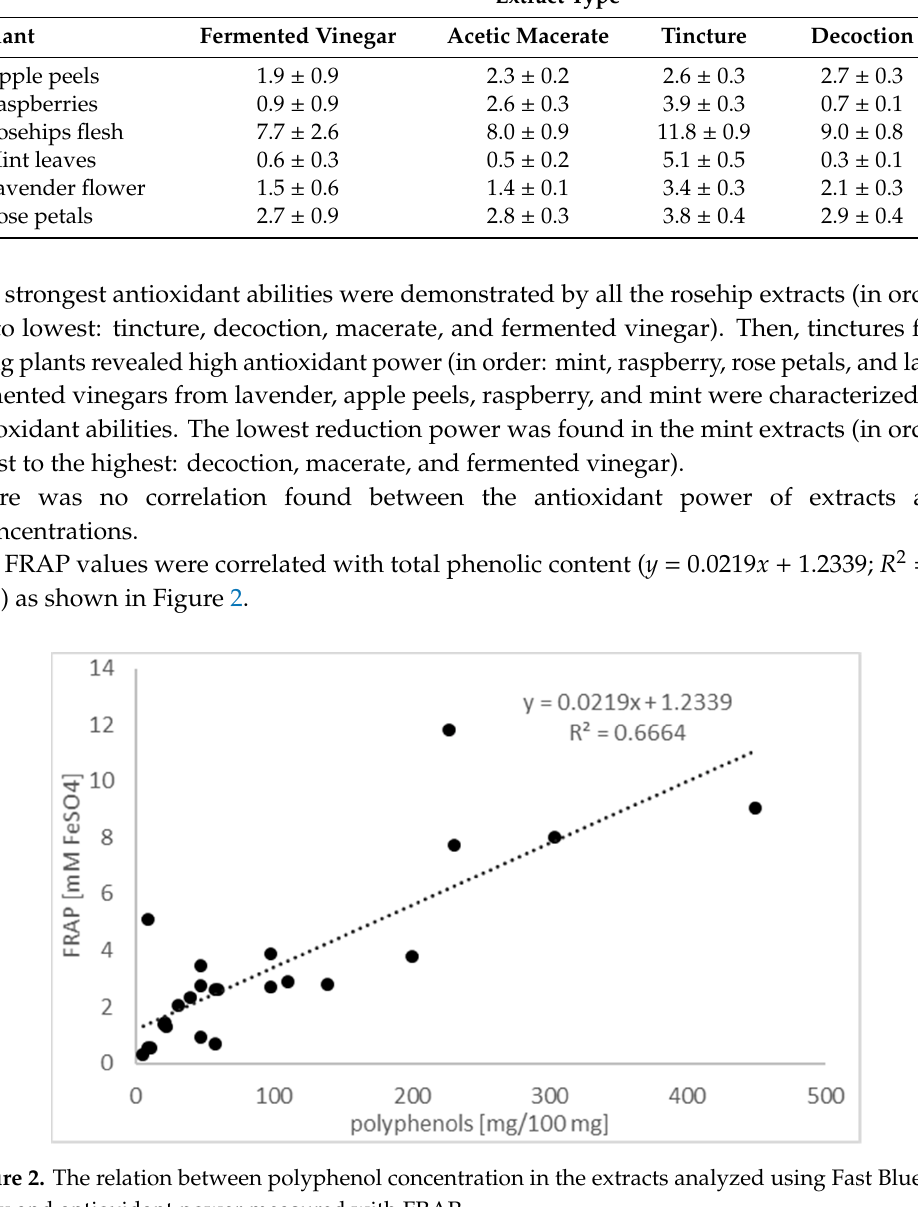
Table 5. Viability of lymphocytes exposed to plant extracts for 1 h at 37 °C. Cell Viability [%Control] ± S.D.